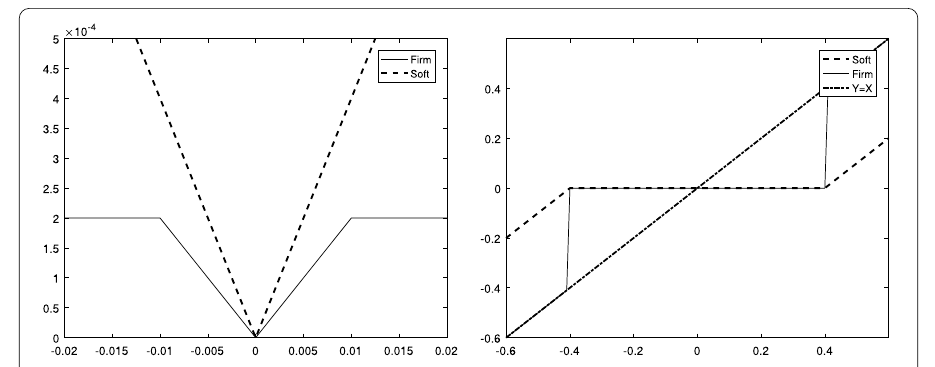
Figure 1 Left the absolute and a -weakly-convex ( τ = 0.04 and a = 4) functions, the right the corresponding proximal mapping